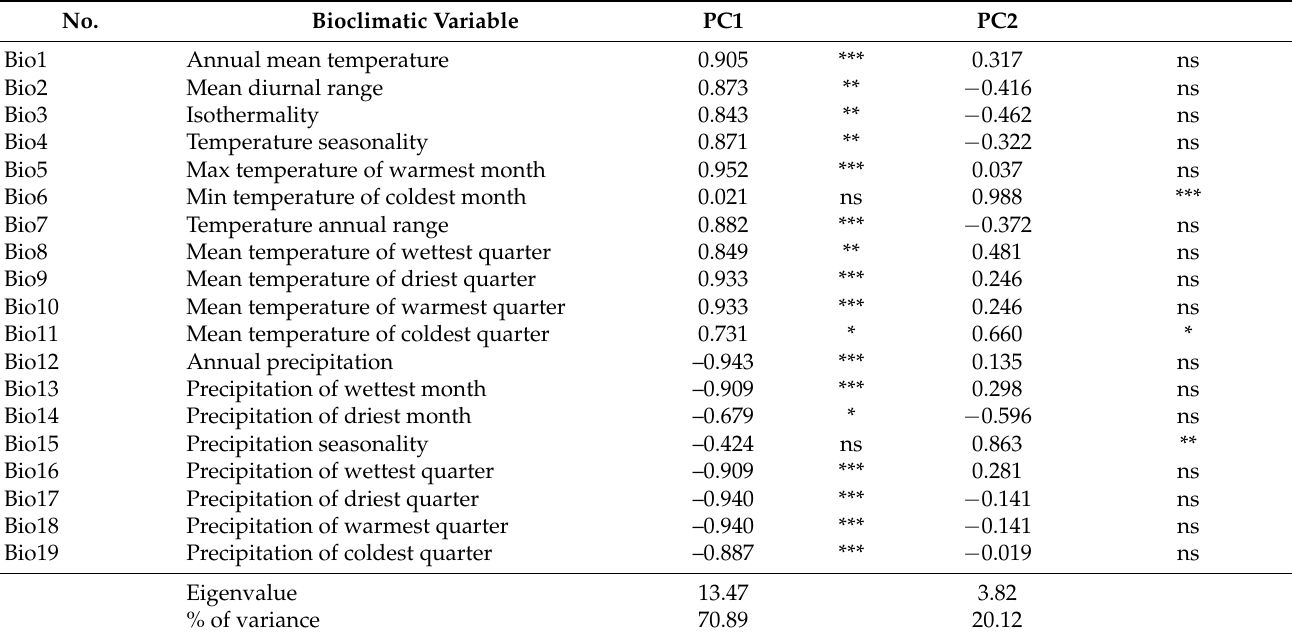
Table 4. Pearson’s correlation coefficients between 19 bioclimatic variables and scores of the first two principal components (PC).